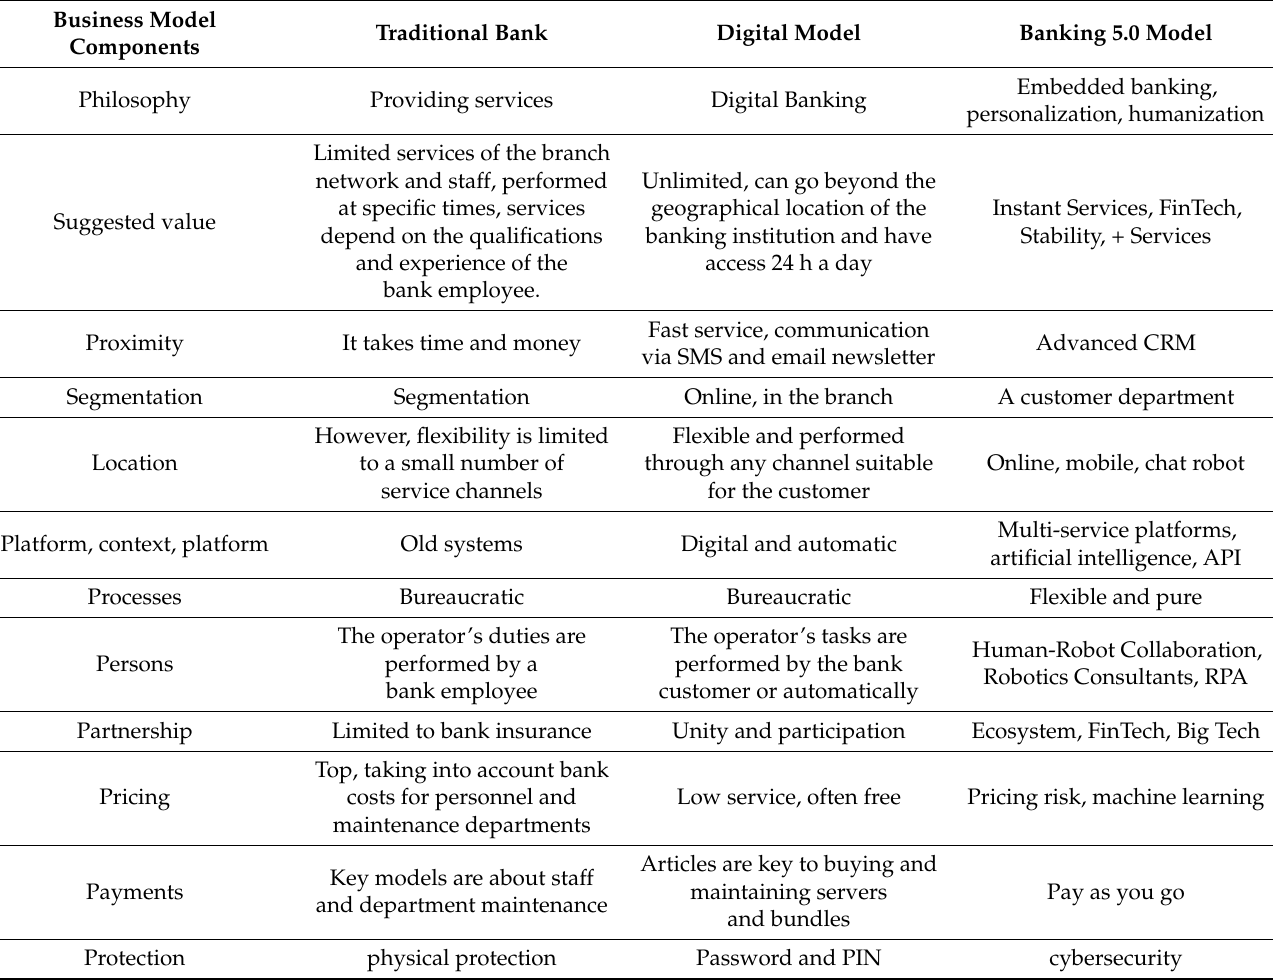
Table 1. Banking 5.0 compared to the past